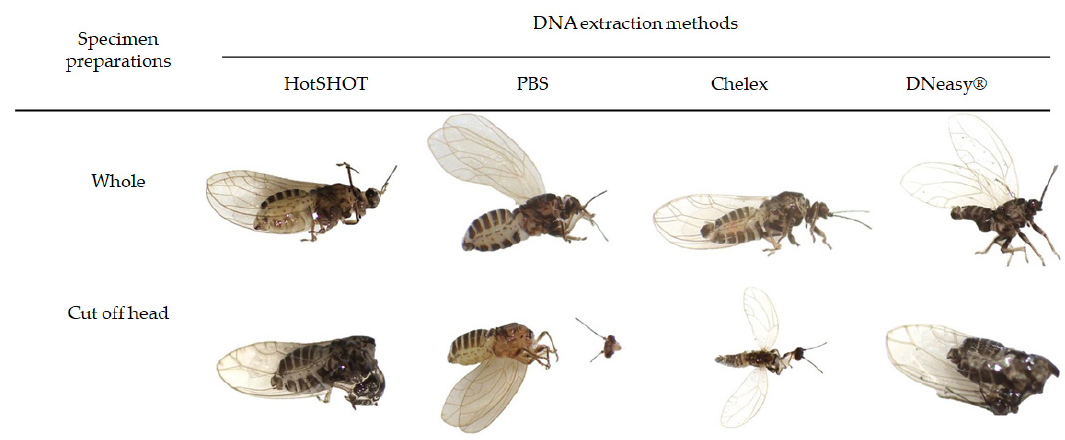
Figure 5. ‘Whole’ and ‘Cut off head’ individuals after DNA extraction with HotSHOT, PBS, Chelex, and DNeasy ® .